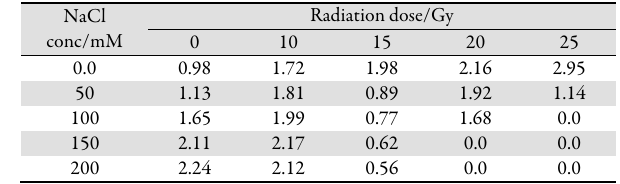
Table 3. The combined effects of gamma radiation doses and NaCl concentrations on total soluble protein (mg/100 g fresh wt) in haploid Nicotiana alata